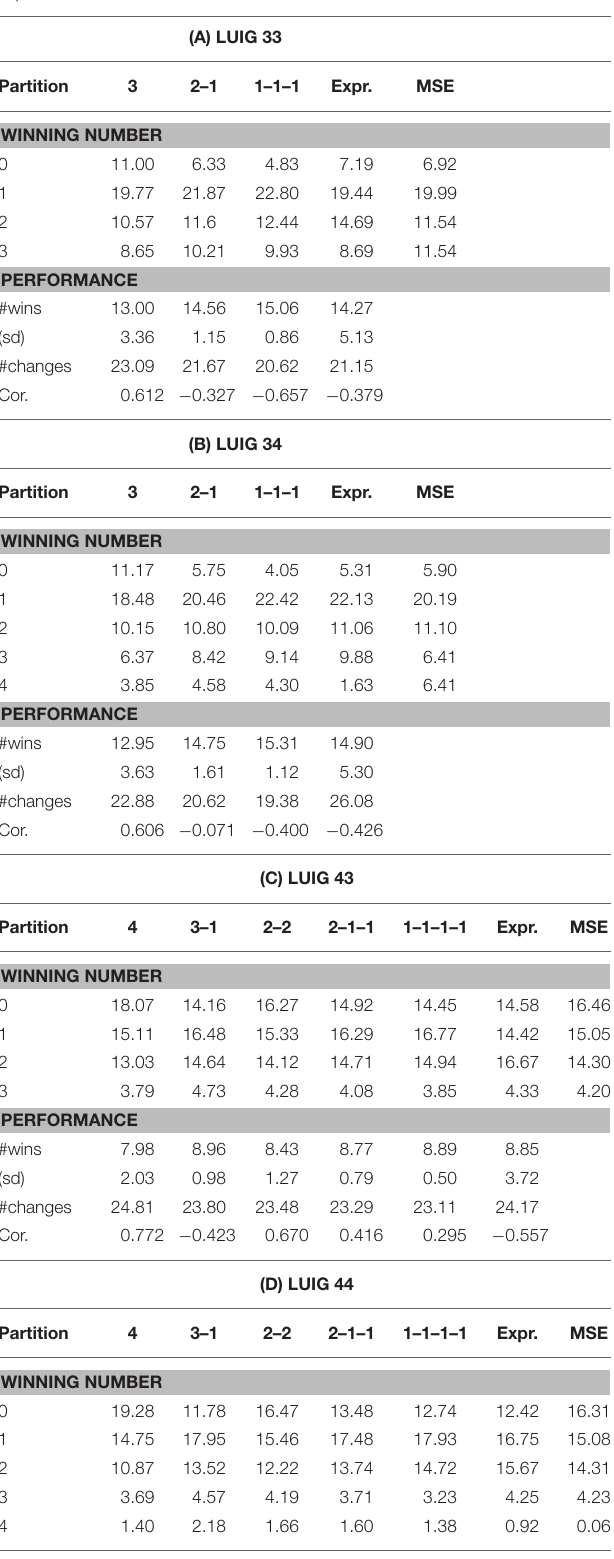
TABLE 3 | Summary statistics of round robin competition in computational